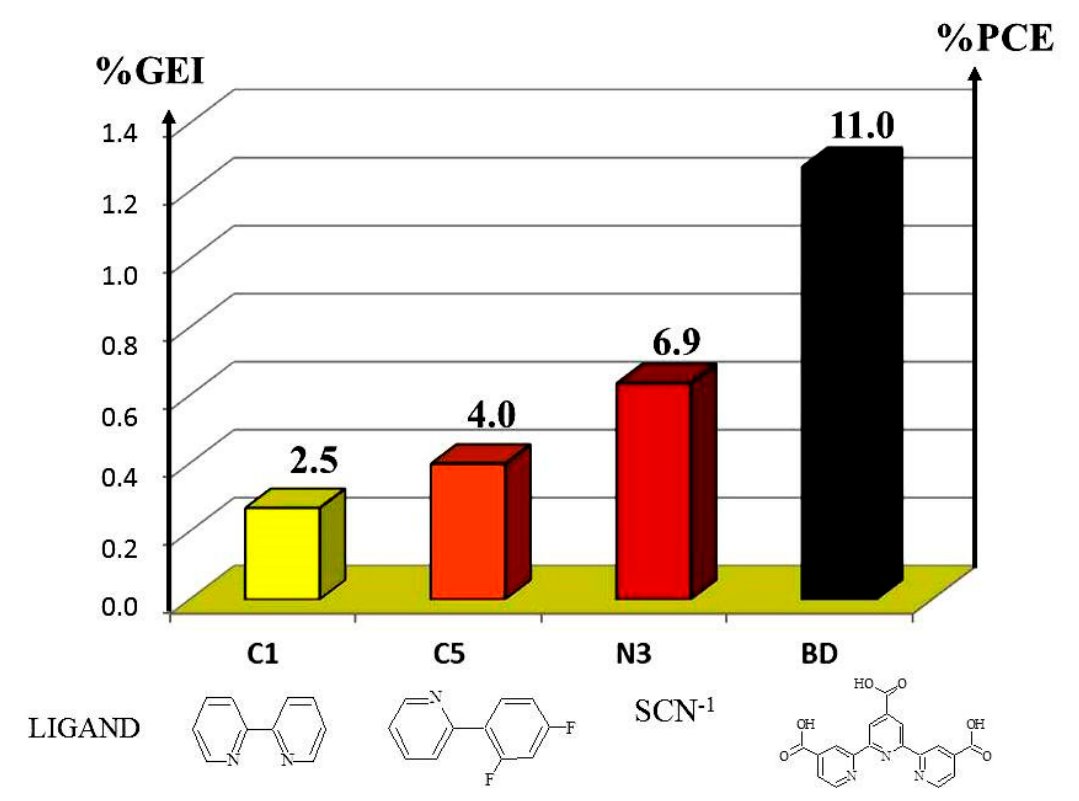
Figure 29. Correlation between GEI and PCE.